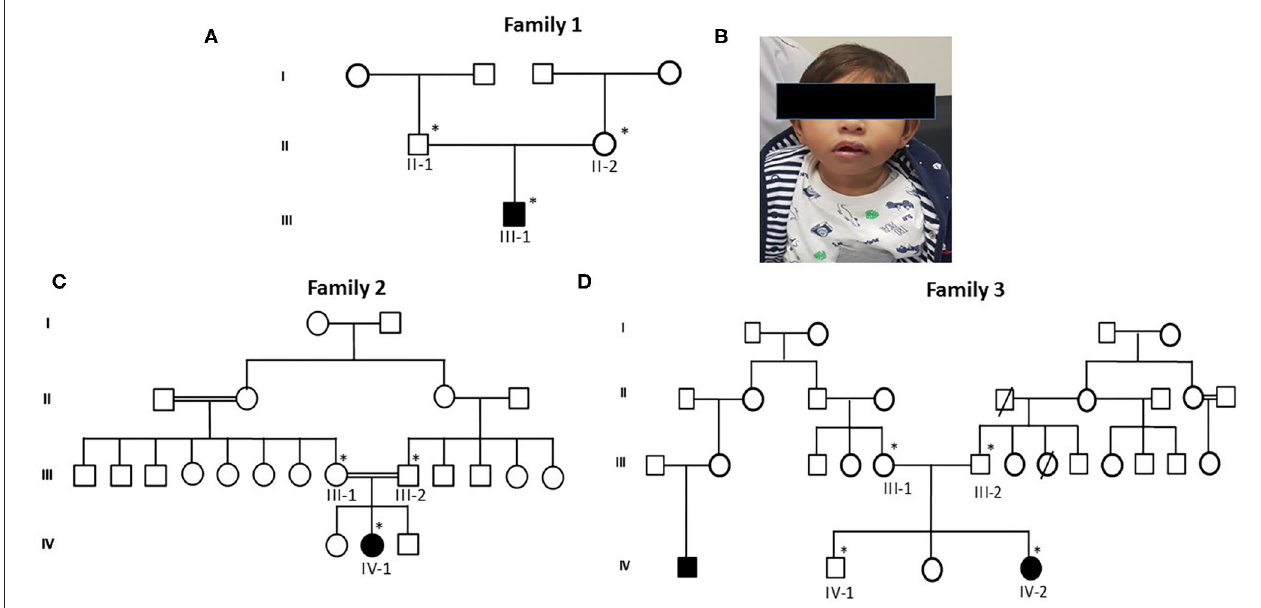
FIGURE 1 | Pedigrees of primary microcephaly families (A,C,D) showing autosomal recessive mode of disease segregation. The open circles and squares showed unaffected females and males. Black filled circles and squares showing the affected members of the families. Double lines between circles and squares represent consanguineous marriage. The asterisk (*) sign represents the family members available for the study. (B) Patients’ facial characteristics represented in photograph showing reduced head circumference and excluded facial